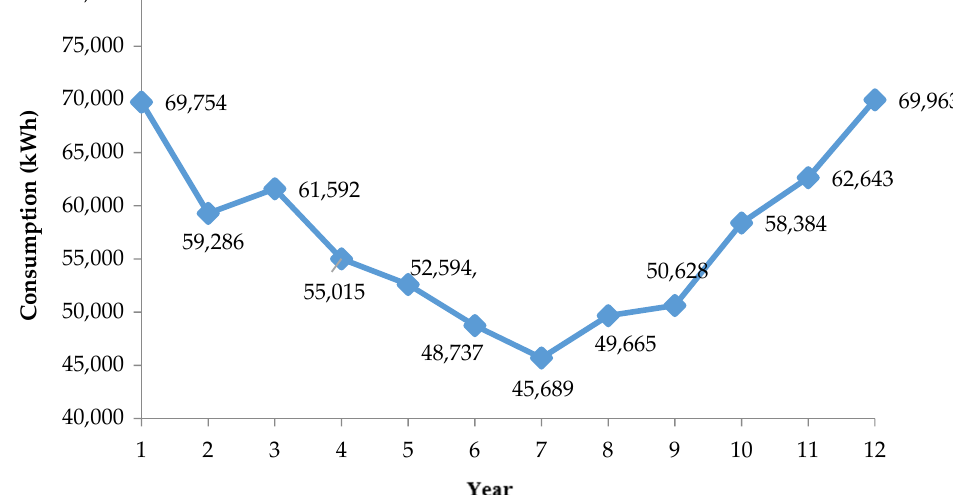
Figure 6. The annual average energy consumption of the faculty building as to the 2017 year.